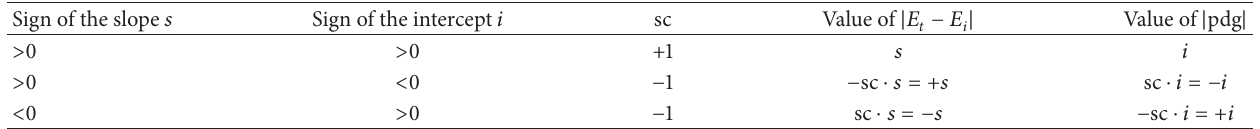
Table 3: Analysis of the physical meaning of the possible signs of the slope and intercept of the regression line (15). Sign of the slope 𝑠 Sign of the intercept 𝑖 sc Value of |𝐸 𝑡 − 𝐸 𝑖 | Value of | pdg | >